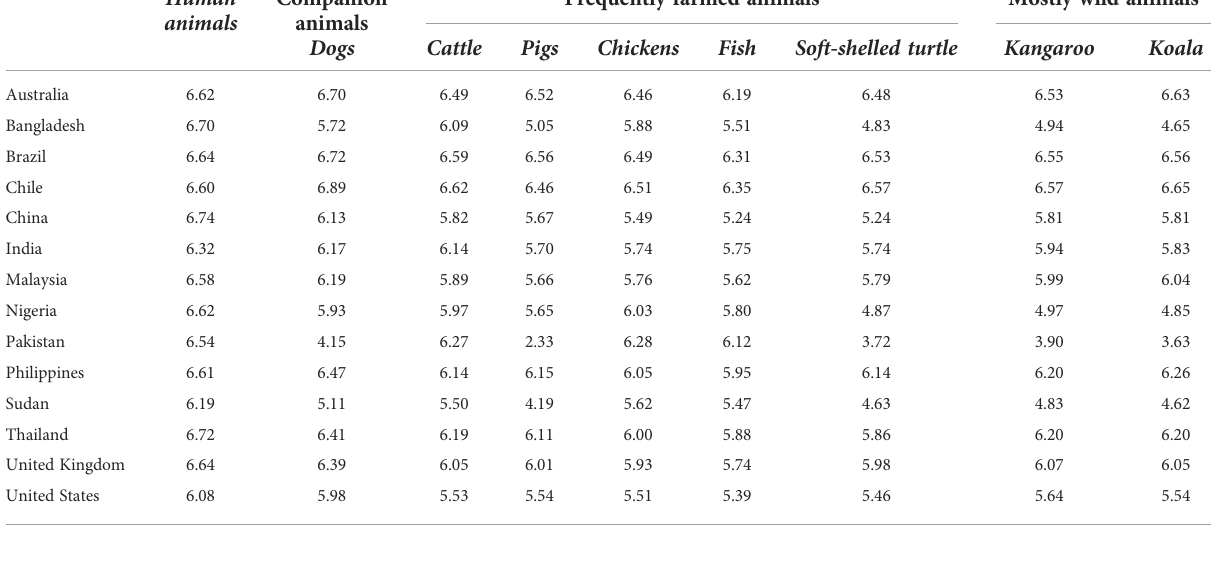
TABLE 3 for the level of importance attributed to the welfare of speci fi c species, by country. Human Companion Frequently farmed animals Mostly wild animals animals animals Dogs Cattle Pigs Chickens Fish Soft-shelled turtle